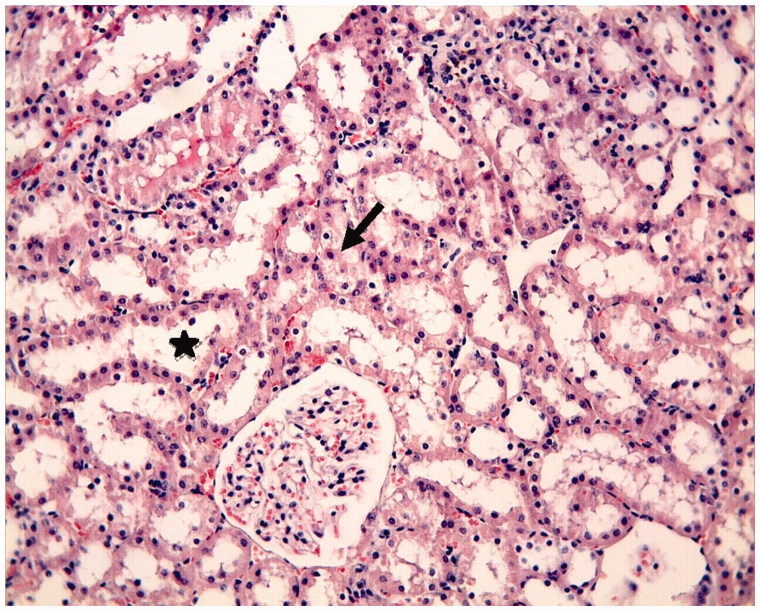
I/R + HP group: tubular dilatation (*) and tubular desquamation (arrow) are observed as being regressed when compared with the I/R group, H–E; ×20.